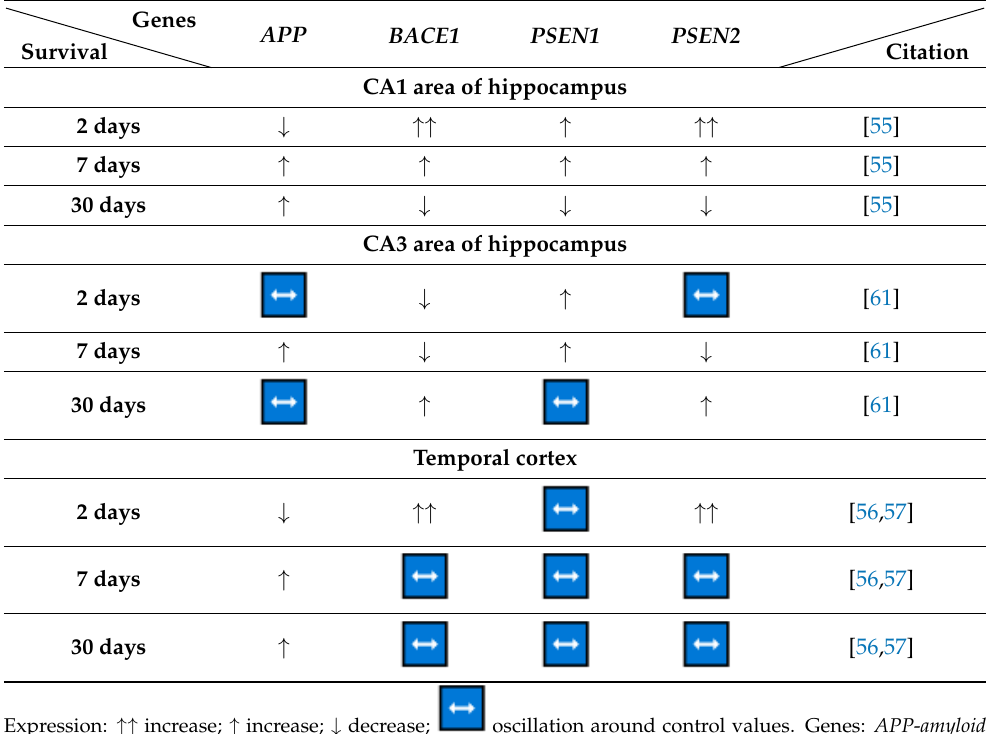
Table 1. AD-linked genes in the hippocampus and temporal cortex post-ischemia.